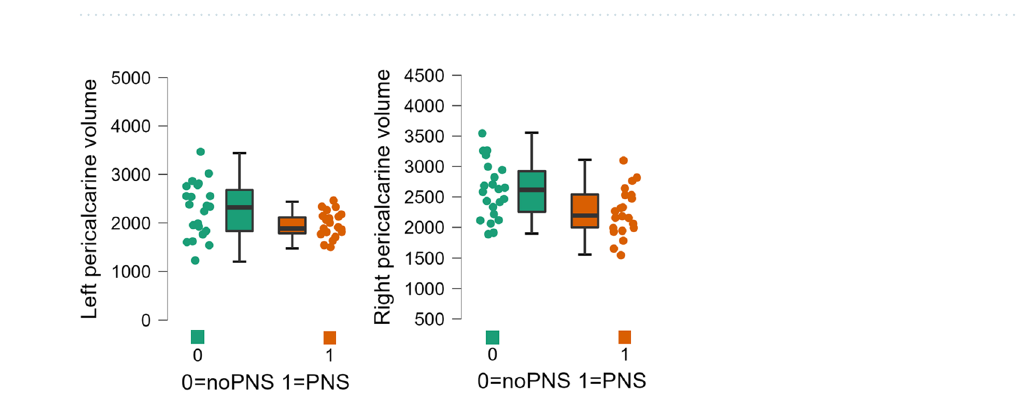
Table 3. Results of cortical volume analysis after FDR-correction.